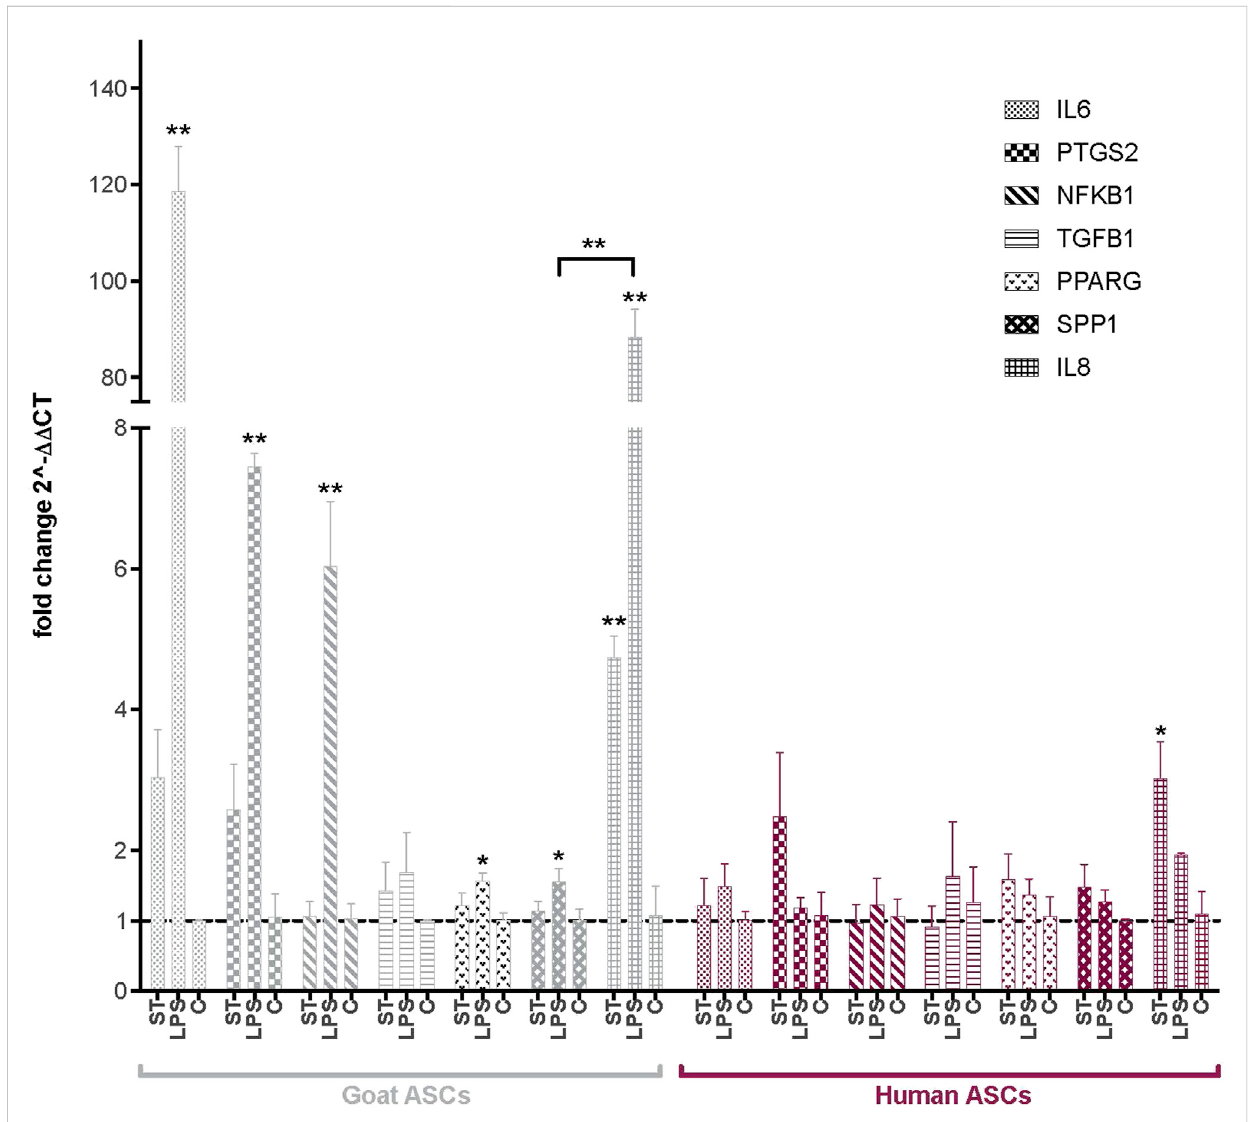
FIGURE 2 Expression ofimmunomodulatoryfactorsinASCspost-microbialassociation.QuantitativePCRanalysisofIL6,PTGS2,NFKB1,TGFB1,PPARG,SPP1, andIL8expressioningoatandhumanASCstreatedwithSTorLPS.Dataispresentedasfoldchange(±SEM)inrelativetoexpressionlevelsinnon-treated cells ( “ C ” ) (fold change ~1, indicated by the dotted line). Statistical signi fi cance of p < 0.05 is denoted by an asterisk (*), and p < 0.01 denoted by two asterisks (**). Goat cell data is presented in gray and human cell data is presented in maroon.